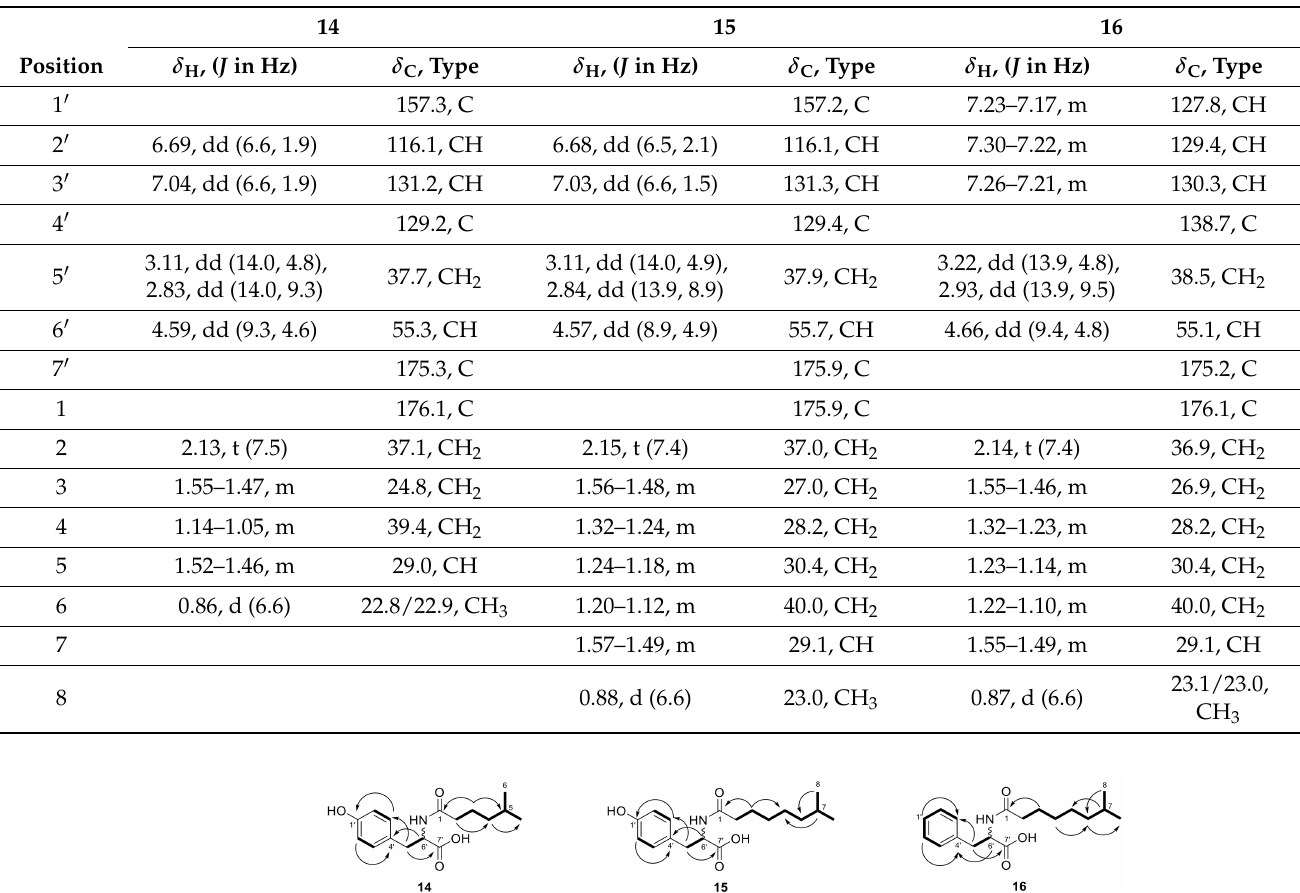
Table 2. 1 H and 13 C data of compounds 14 – 16 ( 1 H: 400 MHz, 13 C: 101 MHz, MeOD- d 4 ).